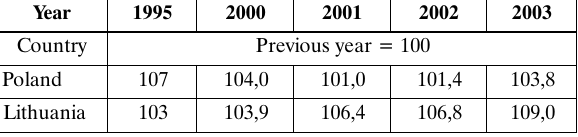
Table 3. Gross Domestic Product per capita in Poland and